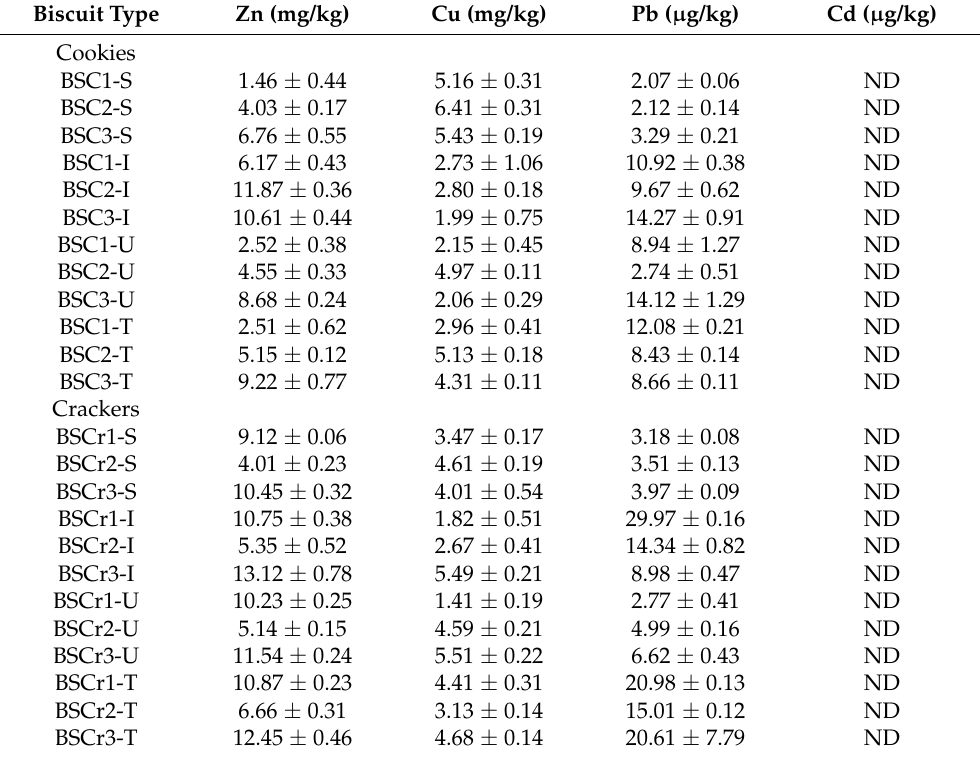
Table 4. Trace elements (Zn, Cu) and heavy metal (Pb, Cd) content of biscuits marketed in Basrah, Iraq. Biscuit